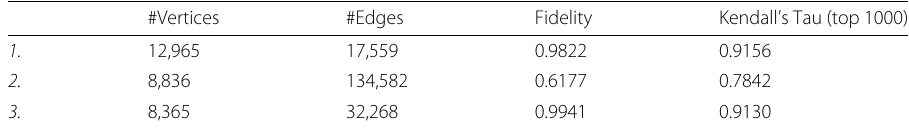
Table 3 High-fidelity Component Selection for three largest components (out of 8998 identified components) of the 50% GOV crawl (with τ = 0.5